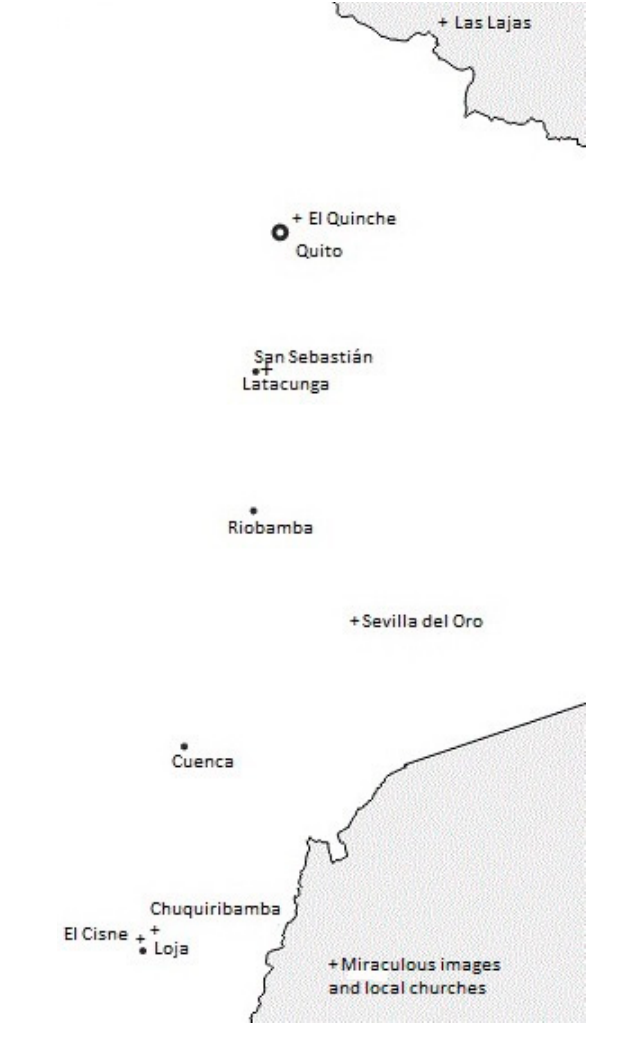
Figure 1. Miraculous images and local churches in Quito in the colonial period (map created by author).